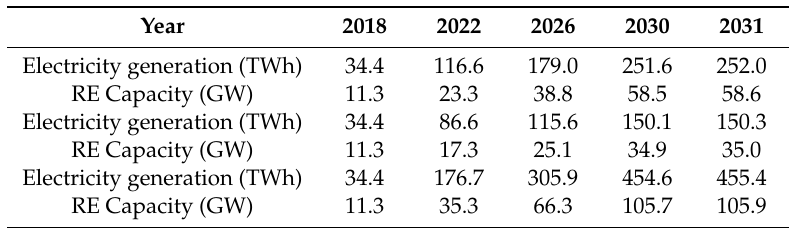
Table 3. RE capacity and generation in each